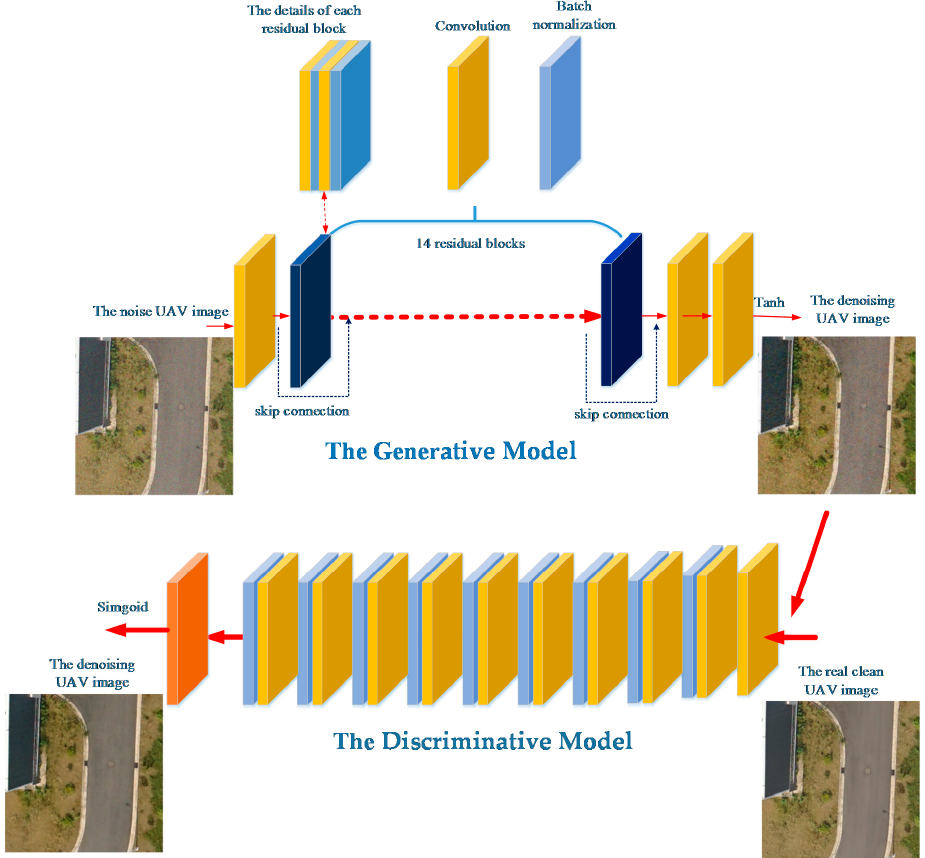
Figure 1. An overview of the proposed DUGAN method. The networks include generative model G and discriminative model D.